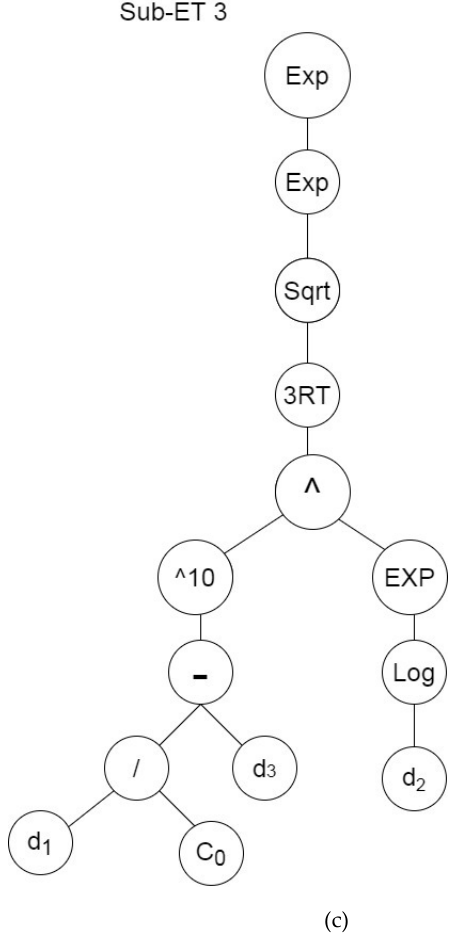
Figure 13. Expression trees of GEP6 for permeability ( a ) sub-ET1, ( b ) sub-ET2, ( c ) sub-ET3.